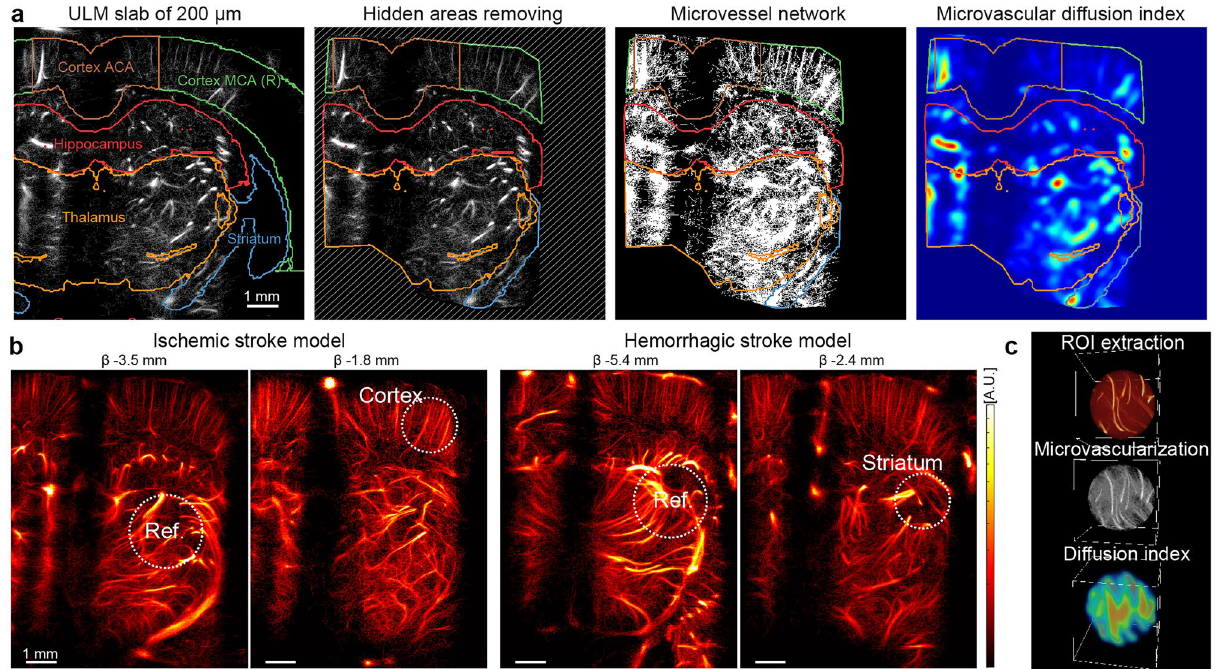
Figure 2. MDI for unsupervised observation reflects the vascularization density. (a) Anatomical regions are extracted from anatomical structures. The hidden areas are excluded from the study. MDI computation with a range of 100 µm on binarized vascularization. ( b) Selection of a round reference region of 1.2 mm diameter in the thalamus and a region of interest in the cortex for ischemic stroke (0.9 mm diameter) and in the striatum for hemorrhage. ( c) Example of a spherical ROI extracted from the ULM volume, binarization and MDI computation. Figures were created with ( a , b ) MatLab 2019a (https:// www. mathw orks. com/ produ cts/ matlab), ( c ) Amira 2019.4 (https:// www. therm ofish er. com/ amira-